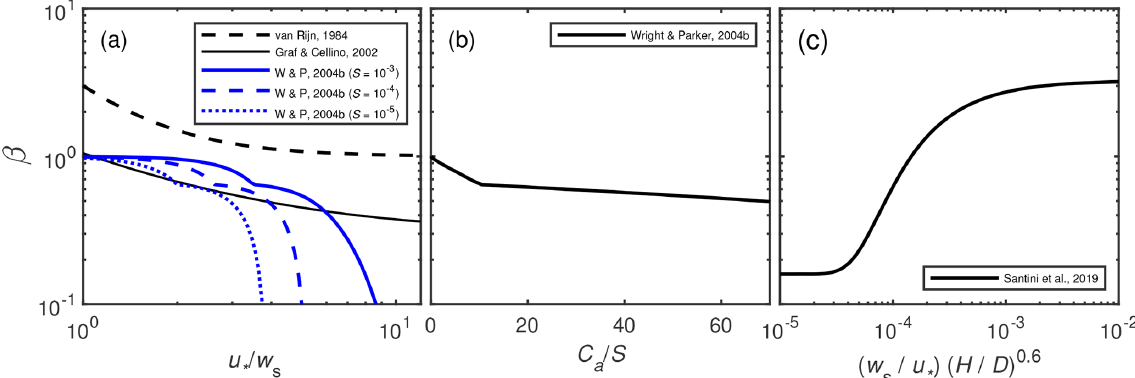
Figure 2. Existing relations for the factor β (Eq. 2) as a function of (a) shear velocity normalized by setting velocity u ∗ /w s (van Rijn, 1984; Graf and Celino, 2002; Wright and Parker, 2004b), (b) near-bed concentration normalized by slope C a /S (Wright and Parker, 2004b), and (c) w s /u ∗ ( H/D ) 0 . 6 as proposed by Santini et al. (2019). In panel (a) , the Wright and Parker relation (denoted W & P) used C a calculated from the entrainment relation of Wright and Parker